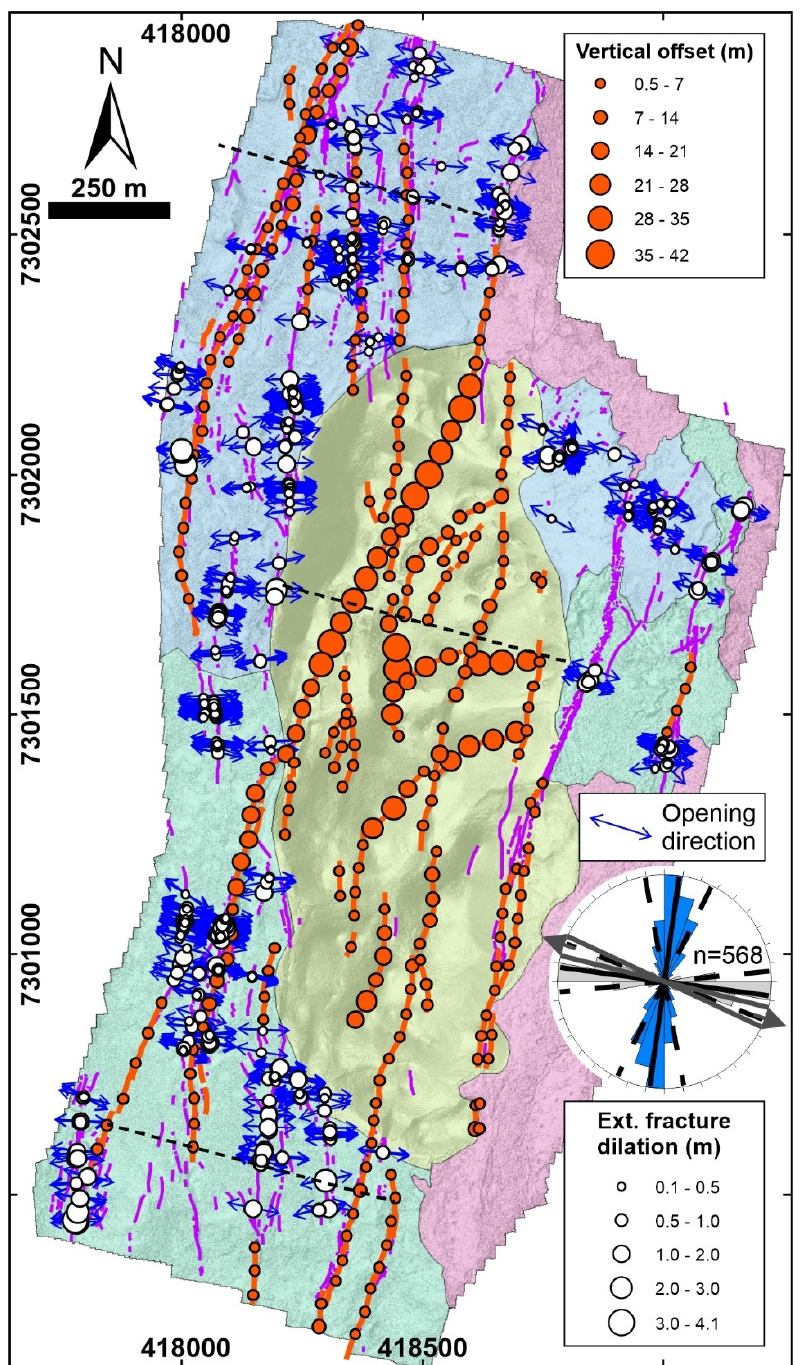
(Figure 7): all these data have been collected in the post-LGM units (no extension fractures in historical lavas or in LGM units). Appl. Sci. 2020 , 10 , x FOR PEER REVIEW